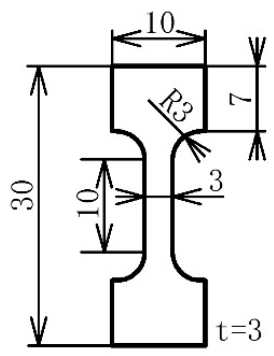
Figure 1. Shape and dimensions of the test piece (mm).